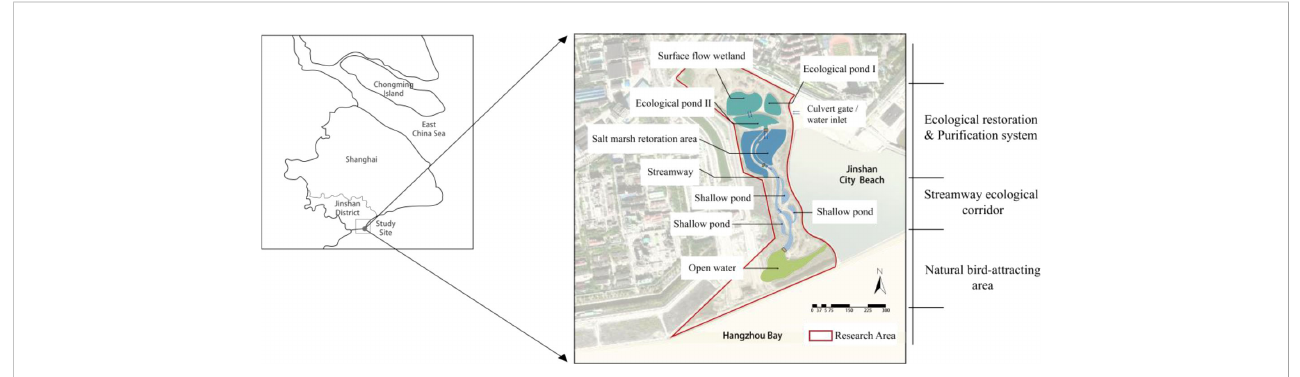
FIGURE 1 Location of the Study Area and Engineering